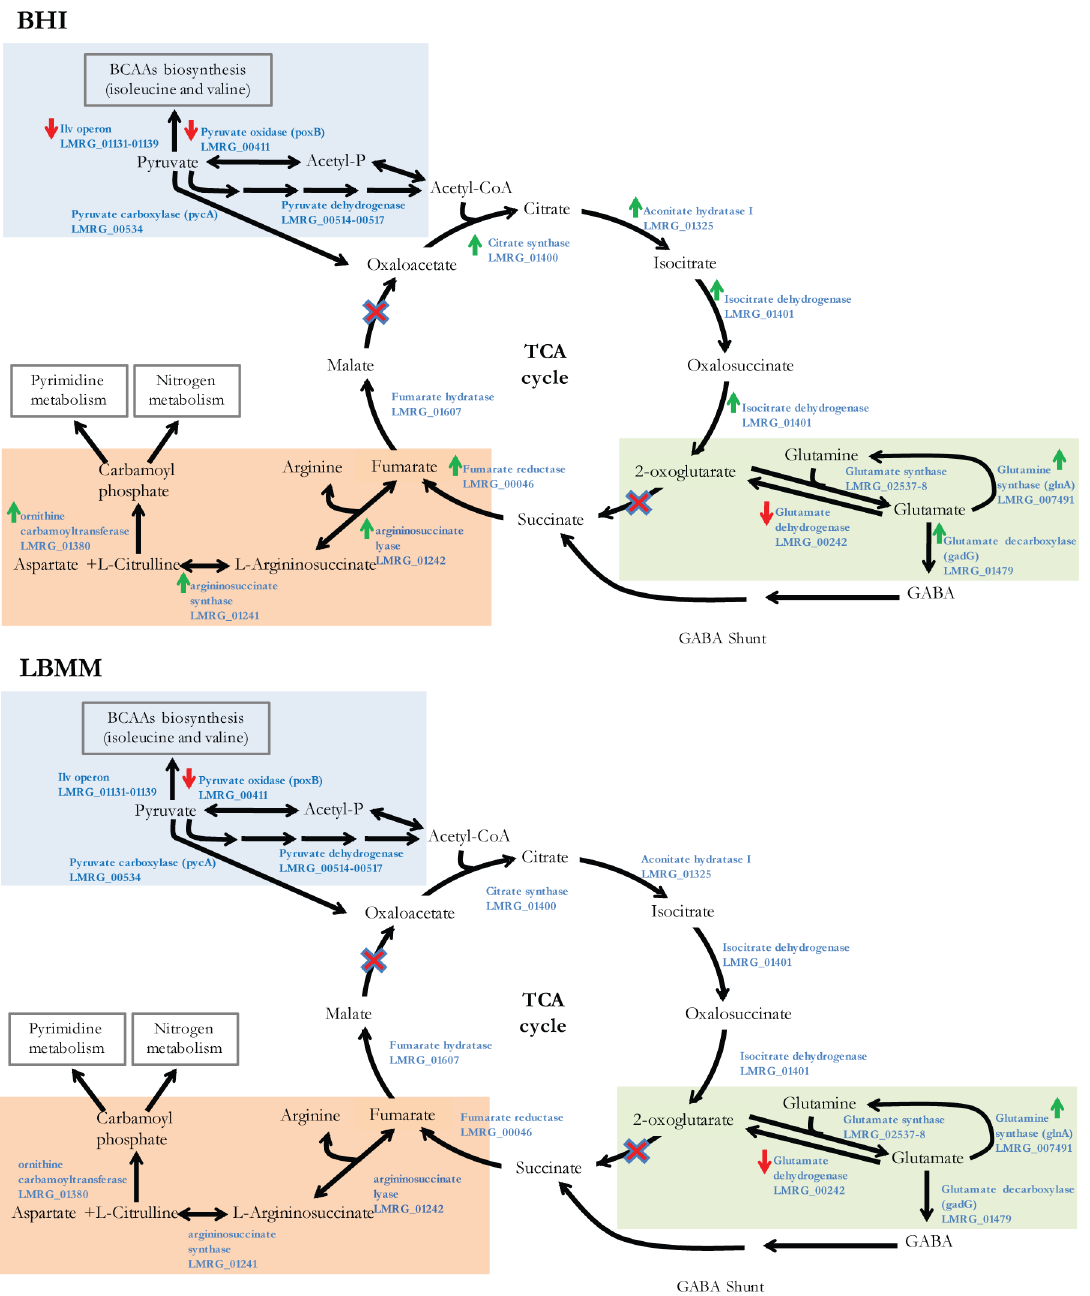
Fig 8. A Model for CodY regulation of L . monocytogenes central metabolism. Illustration of central metabolic pathways that are regulated by CodY in L . monocytogenes in BHI A. and LBMM B. In light blue — pyruvate metabolism, light green — nitrogen metabolism, light orange — arginine metabolism, in the middle the TCA cycle. Green arrows represent enzymes that are induced by CodY, while red arrows represent enzymes repressed by CodY, based on the RNA-Seq analysis.